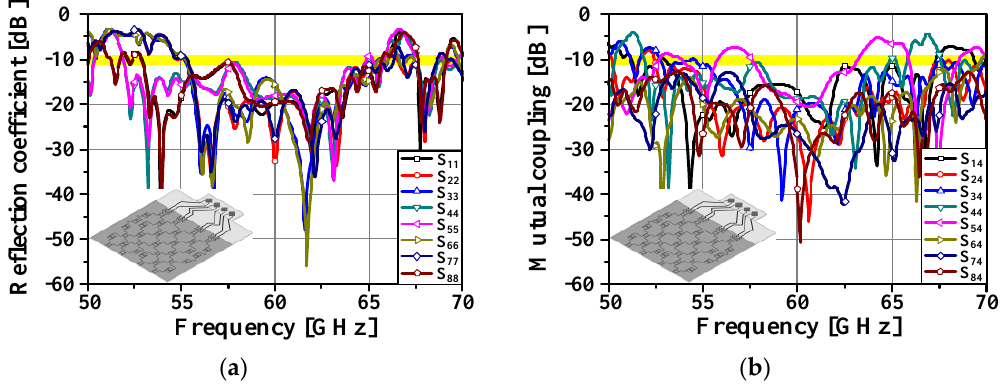
Figure 11. Simulated results of the proposed antenna array system: ( a ) reflection coefficient and ( b ) mutual coupling.